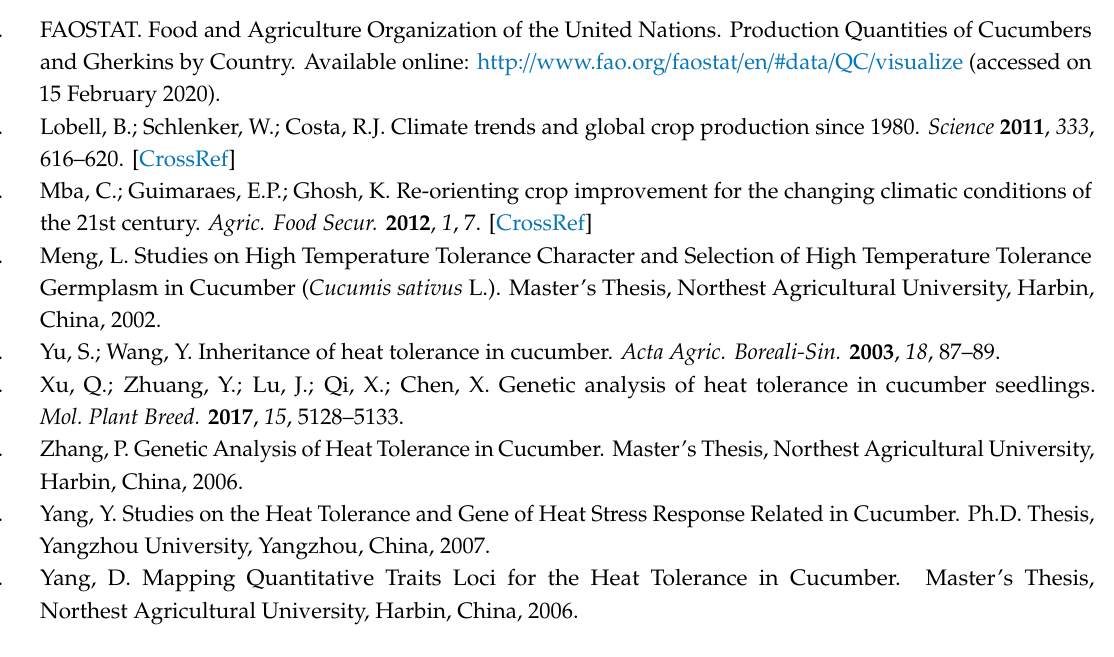
Table S1: Phenotypic data of thermotolerance in HR population, Table S2: Phenotypic data of thermotolerance in HP population, Table S3: Candidate genes within the major QTL qHT3.2, Table S4: Heat stress treatment conducted at Shunyi, Beijing (SY), Table S5: Heat stress treatment conducted at Nankou, Beijing (NK), Table S6: Oligos used for